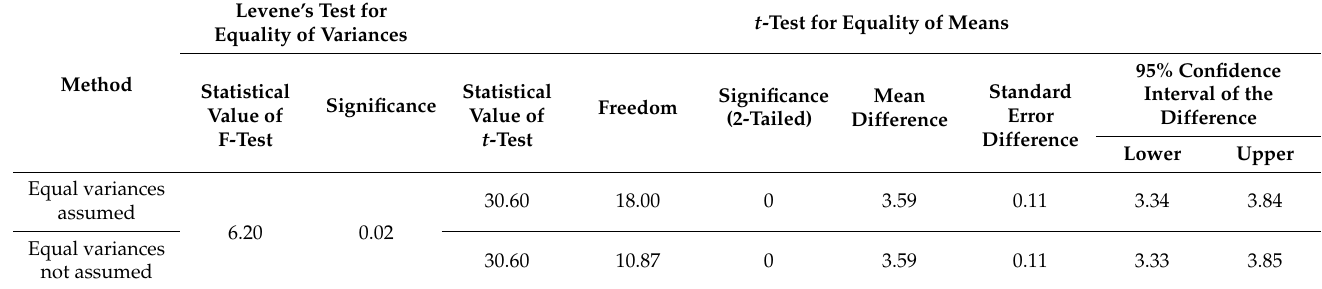
Table 14. t -Test result of color difference before and after aging resistance.